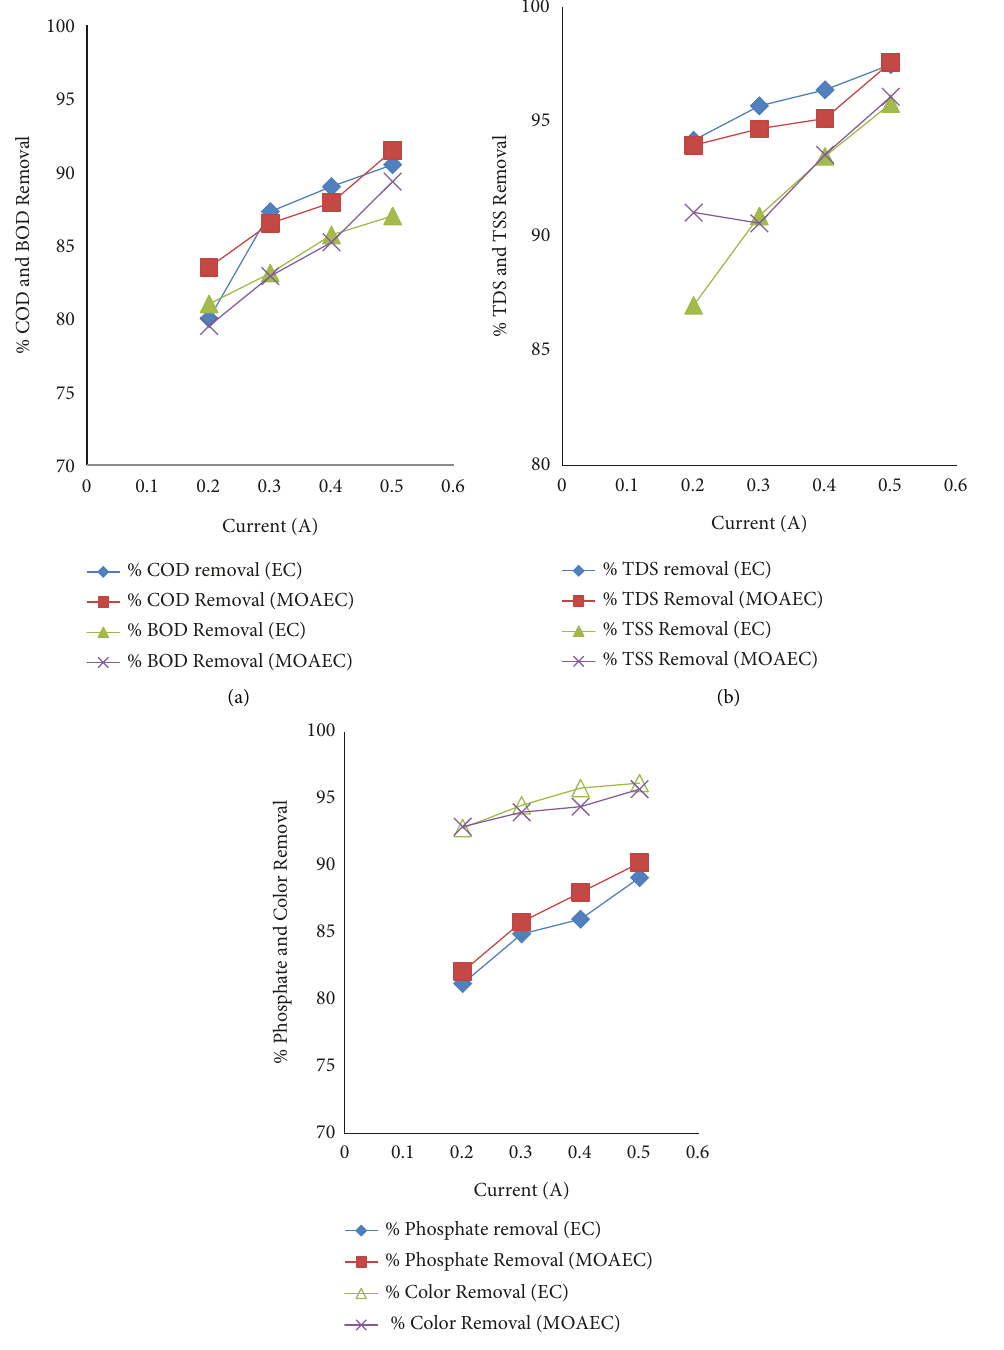
Figure 7: Effects of current on COD and BOD removal efficiency (a), TDS and TSS removal efficiency (b), and phosphate and color removal efficiency (c) using EC process and Moringa Oleifera -assisted EC process